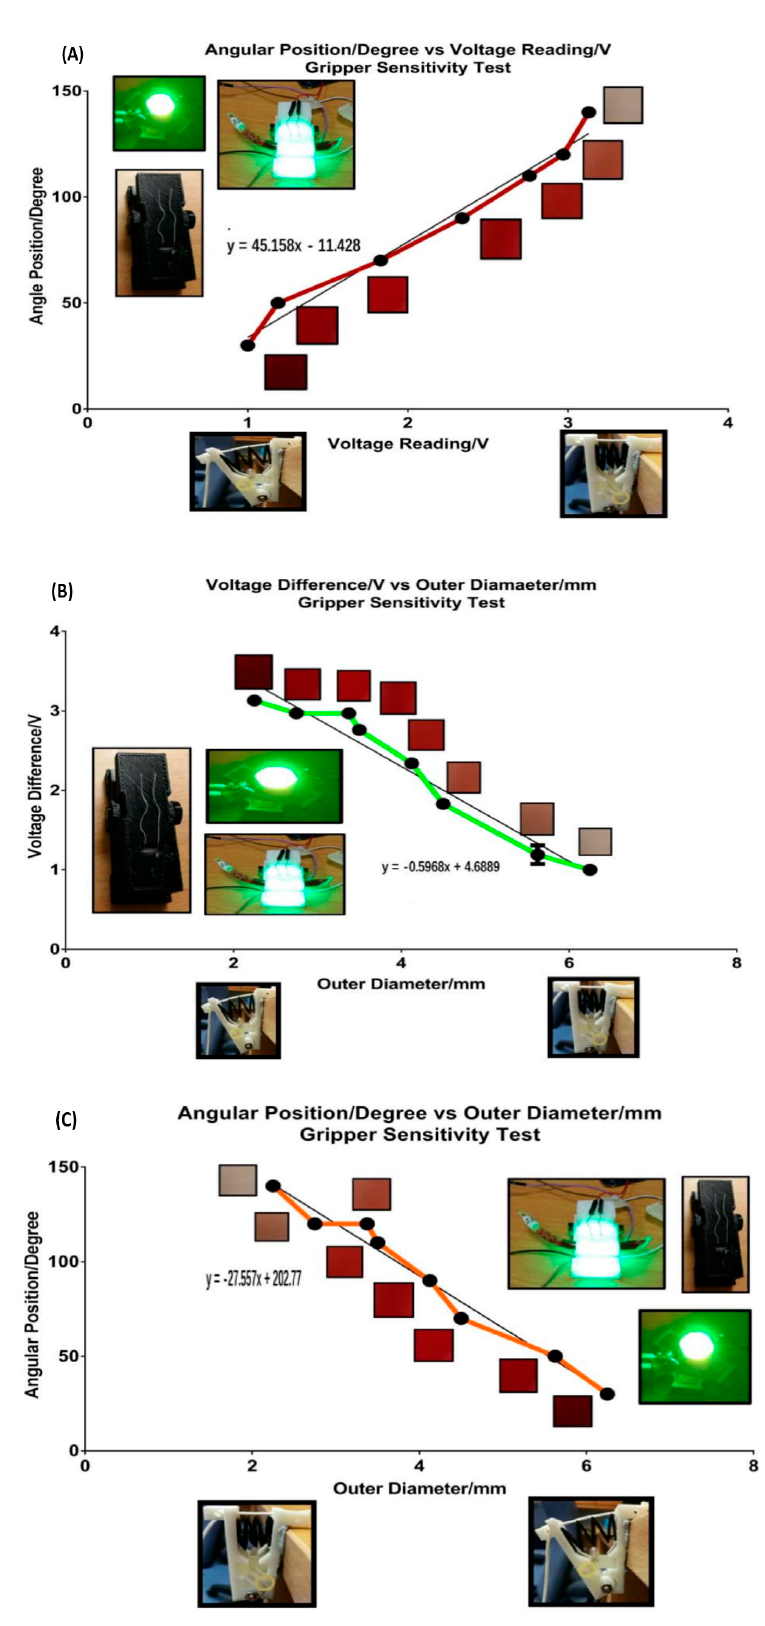
Figure 10. The relationship between Angular Position of Servo motor and Voltage Reading of LDR, as shown in ( A ). The relationship between Voltage Di ff erence and Outer Diameter, as shown in ( B ). The relationship between Angular Position of the servomotor and Outer Diameter of Saline Tube, as shown in ( C ).